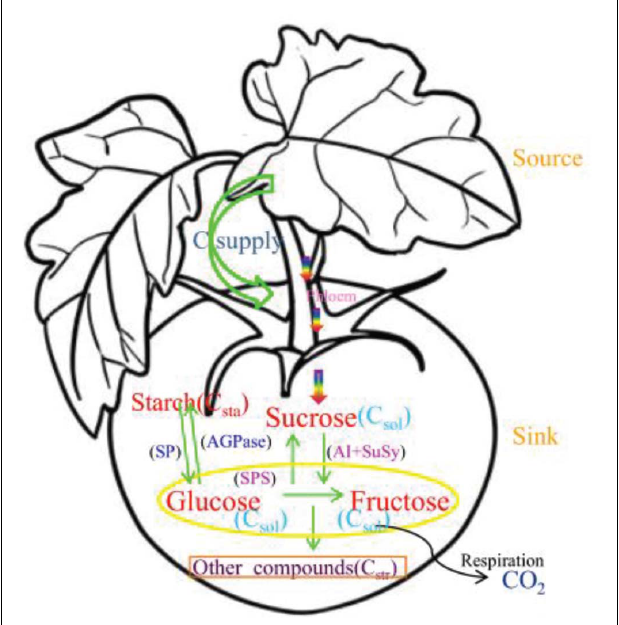
FIGURE 1 | Carbon metabolism and related enzymes in tomato fruit. Arrows represent carbon flows, and the parameters p 1 ( t ), p 2 ( t ), p 3 ( t ), p 4 ( t ), p 4 m ( t ), and p 5 m ( t ) are the relative rates of carbon conversion for fructose, glucose, sucrose, starch and other compounds. The source is the leaf, which supplies carbon; the sink is the fruit, to which carbon is transported. Green arrows show the interconversion of different forms of carbon catalyzed by enzymes in the fruit. The yellow ellipse contains glucose and fructose, which are the main sugars in the tomato, orange rectangle denotes other carbon-containing compounds and the black curved line indicates carbon lost through